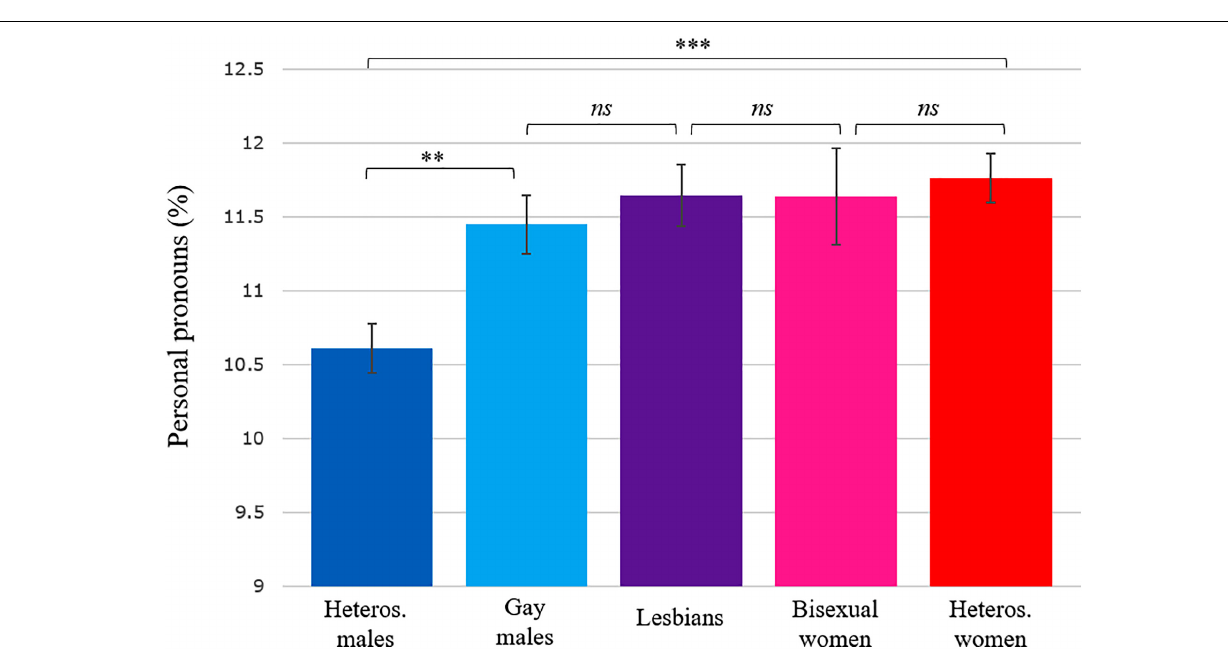
gender-egalitarian countries, which is the opposite of what the gender role hypothesis would predict (Schmitt et al.,